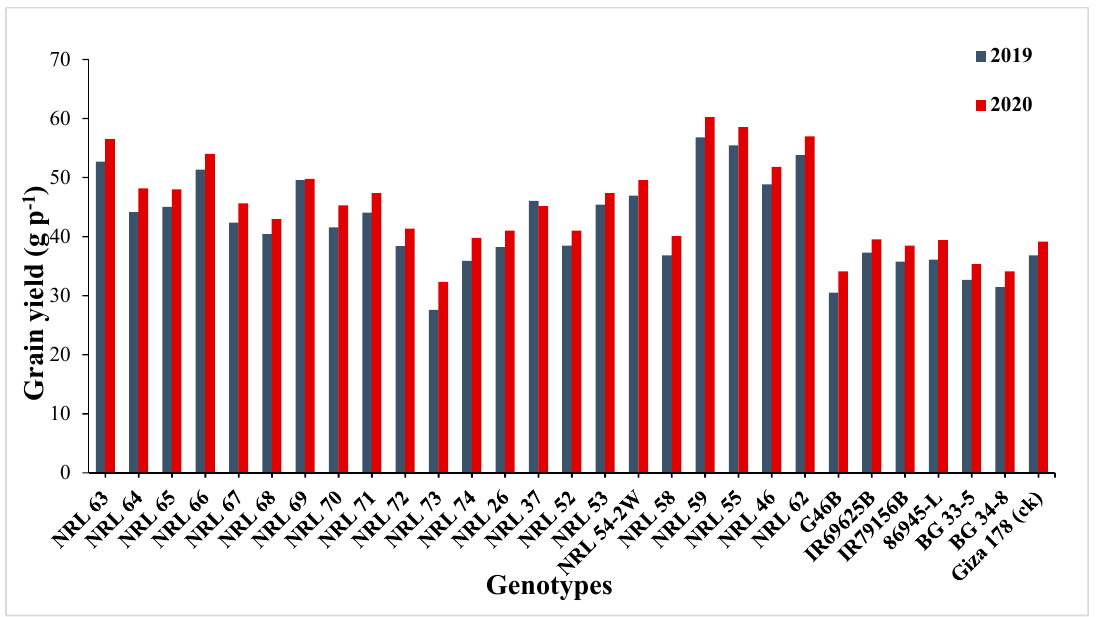
Figure 3. Mean performances for grain yield per plant (g) of the studied genotypes during 2019 and 2020 growing season.